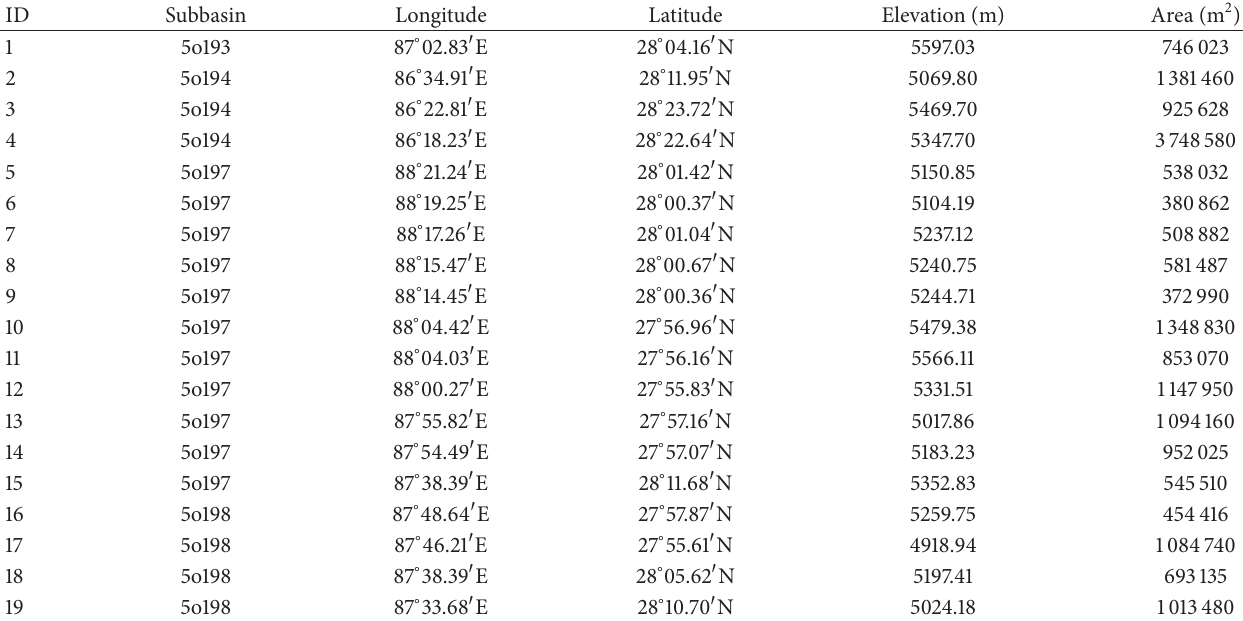
Table 5: Potentially dangerous glacial lakes in the Pumqu river basin.